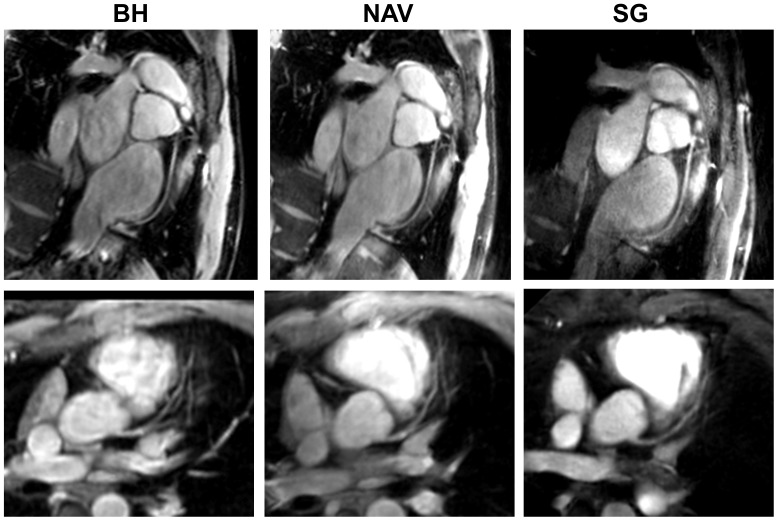
RCA (top row) and LAD (bottom row) images acquired with breath-hold (BH) (left column), free-breathing NAV (NAV) (middle column), and free breathing self-gated (SG) techniques (right column).